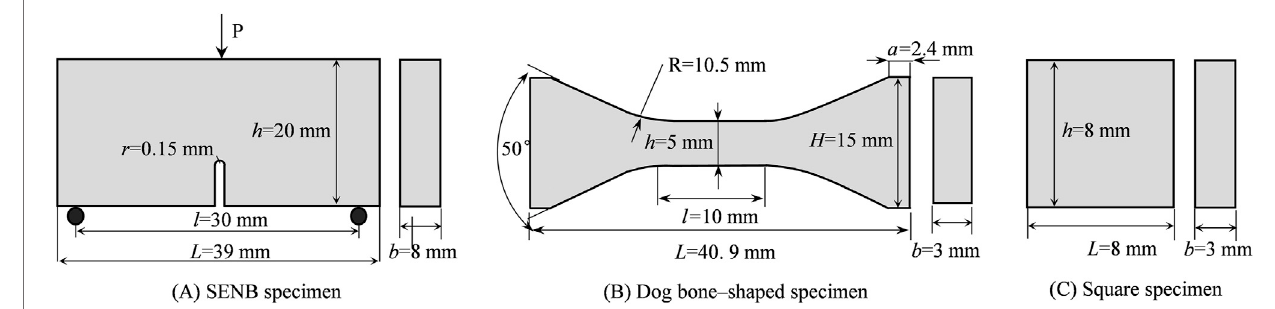
FIGURE 2 | Specimen con fi gurations employed in this study.